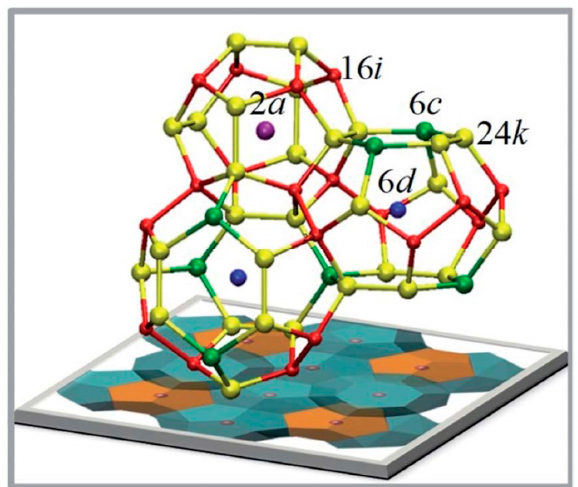
Figure 2 . A view of the type I clathrate structure with the Wyckoff site symbols indicated. The network structure consists of 6 c (green), 16 i (red), and 24 k (yellow) and the two guest sites are denoted by 2 a (magenta) and 6 d (blue). Reproduced from He, Y.; Sui, F.; Kauzlarich, S.M.; Galli, G. Si-based Earth abundant clathrates for solar energy conversion. Energy Environ. Sci. 2014 , 7 , 2598–2602 [11] with permission from The Royal Society of Chemistry.